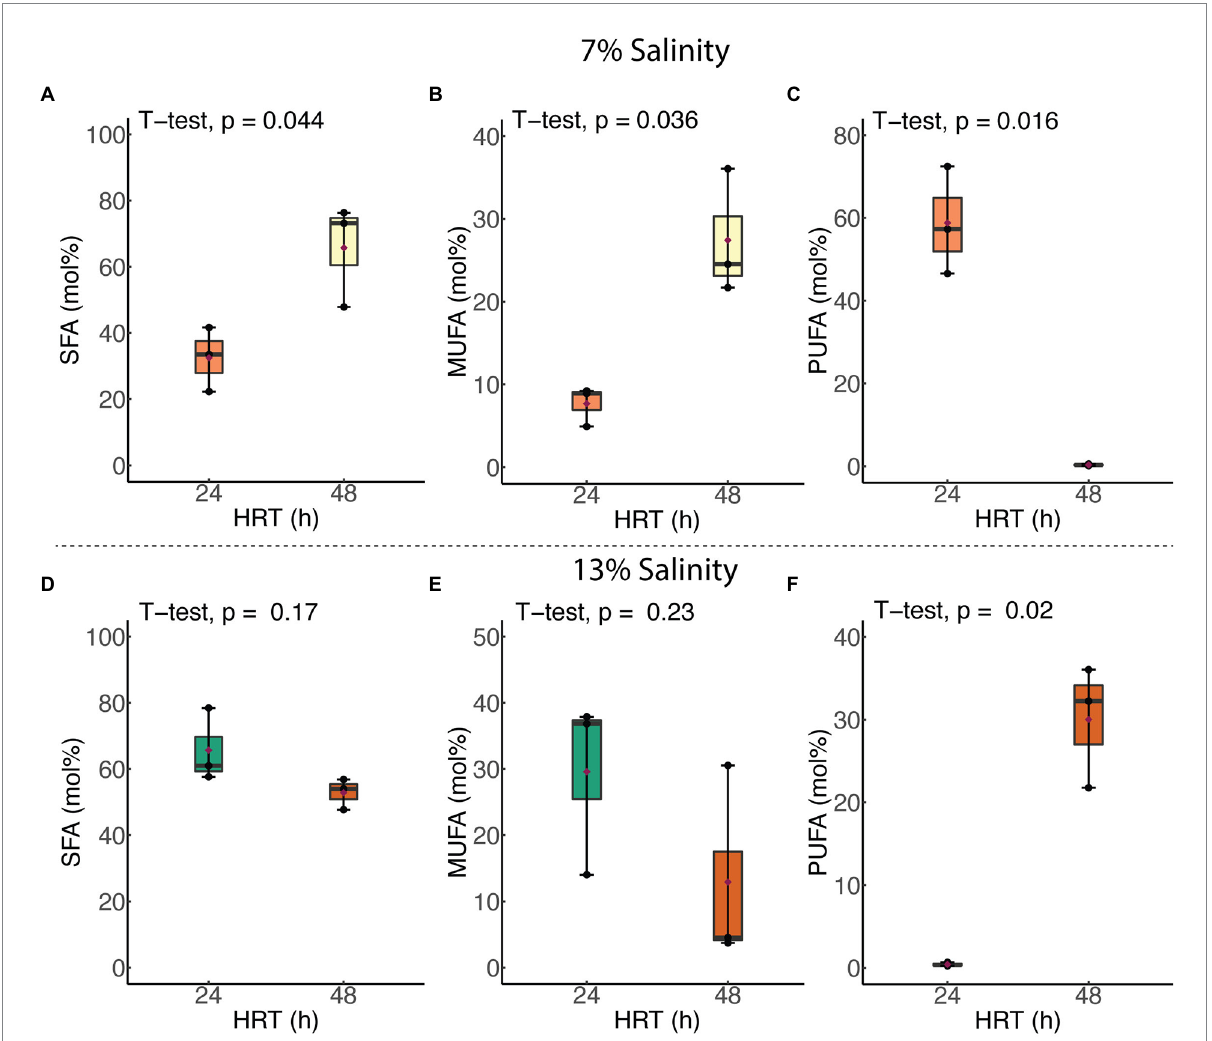
FIGURE 5 Variations in abundances of membrane PLFA classes in H. congolense WG10 with hydraulic retention time at constant temperature (40 ° C), evaluated at two different salinities – 7% (A–C) and 13% (D–F) . p -Values are obtained from student’s t -test of independent groups. Variation is considered significant at α ≤ 0.05. SFA, Saturated fatty acid; MUFA, Monounsaturated fatty acid; PUFA, Polyunsaturated fatty